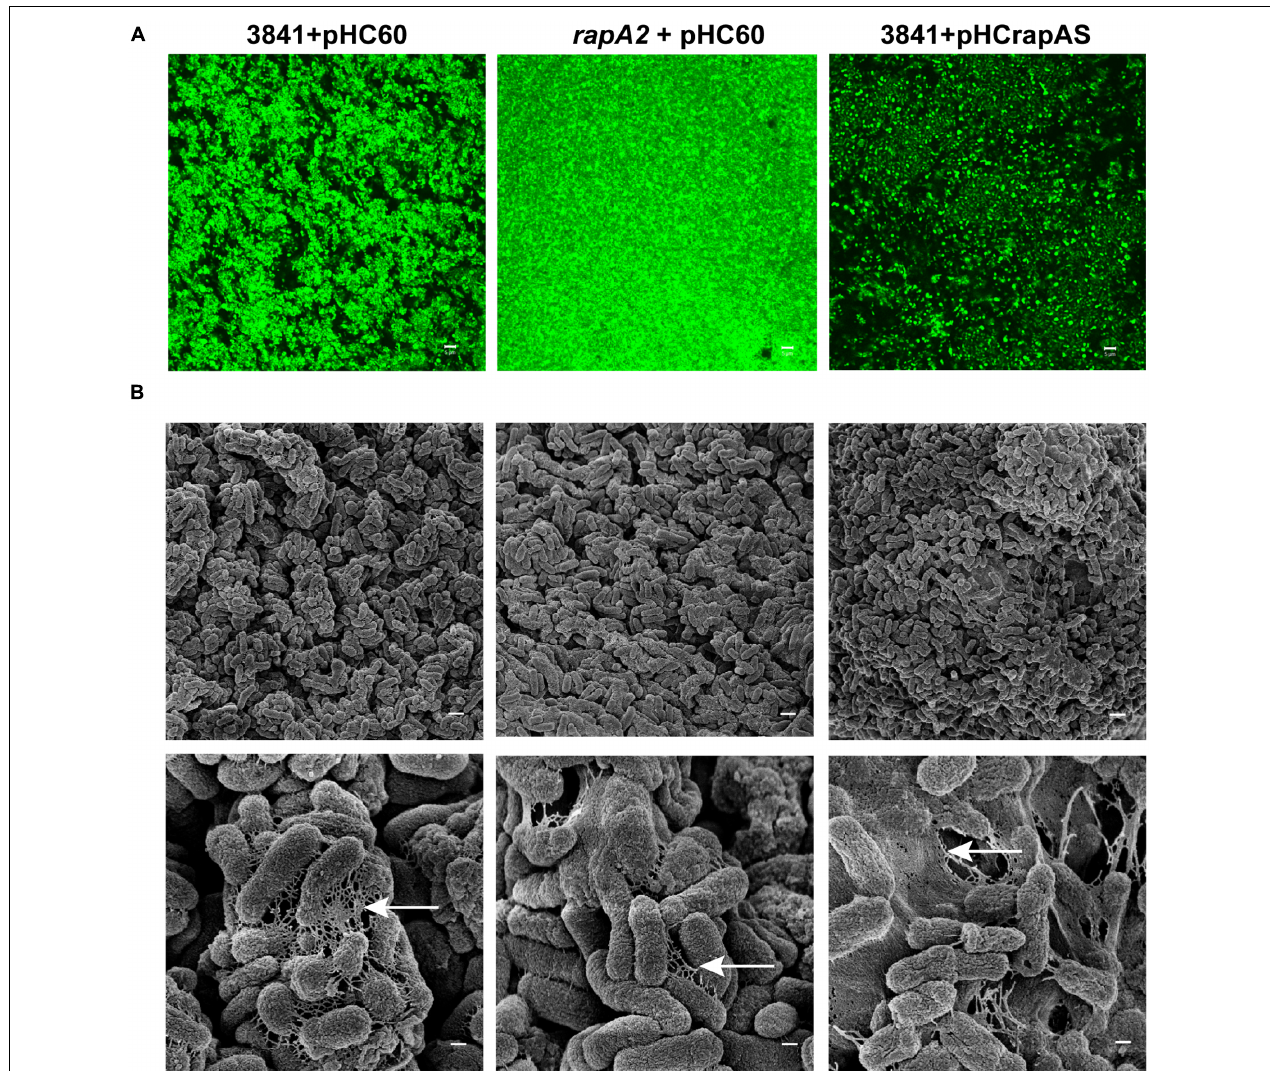
FIGURE 3 | Microscopic analysis of Rhizobium biofilms grown on semisolid medium. 3841 derivative strains grown on TY-agar plates for 4 days were visualized by (A) CSLM and (B) Scanning Electronic Microscopy (SEM). (A) Biofilms of GFP-labeled 3841 pHC60, rapA2 pHC60 and 3841 pHCrapAS strains are shown. Representative CSLM images from three independent experiments were obtained using a C-Apochromat 63x/1.2 Water Objective from a Carl Zeiss PASCAL LSM 5. White bar: 5 µ m. (B) Cells and the matrix surrounding them in the biofilms formed by the wild type 3841 and derivative strains were observed by SEM in a ZEISS SUPRA 40 microscope. White bar: 1 µ m, magnification at 10.000 X (upper panel). The disposition of the matrix among cells is indicated by arrows. White bar: 200 nm, magnification at 50.000 X (lower